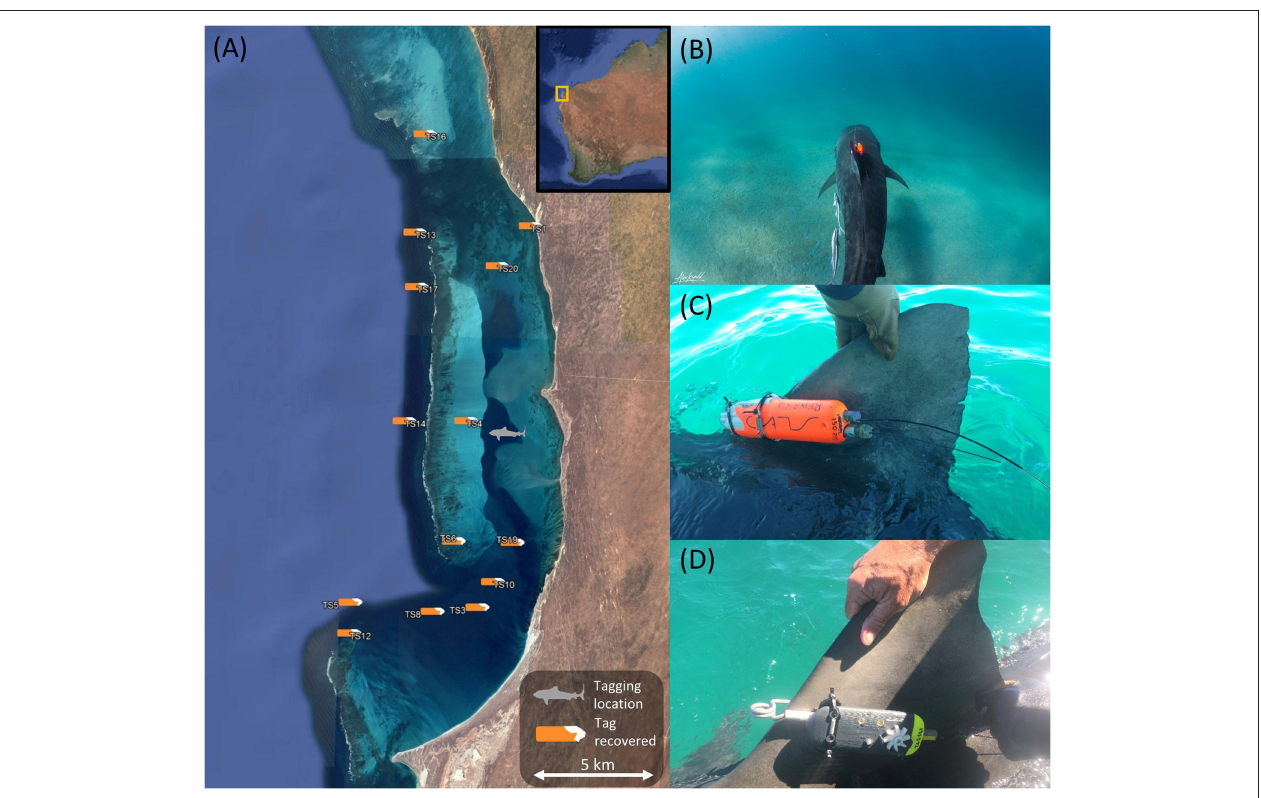
FIGURE 1 | Tagged tiger sharks at Ningaloo Reef. (A) Location of tag deployments and recovery. Eight tags were recovered outside of the bounds of this map to the west and north. (B) Tiger shark post-release. Photo courtesy of Alex Kydd. (C) CATS Cam tag clamped to the dorsal fin. (D) CATS Diary tag clamped to the dorsal